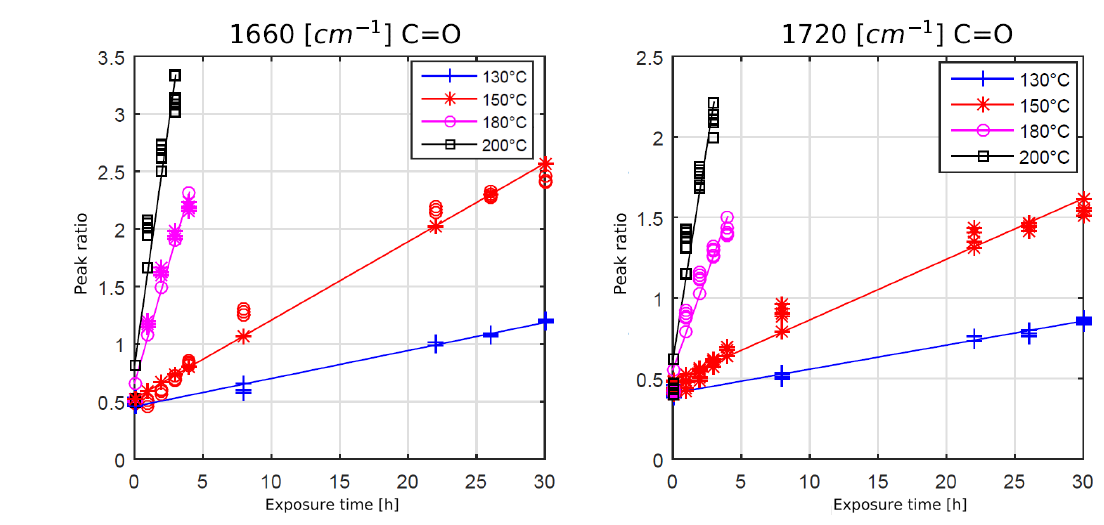
Figure 7. Development of carbonyl bonds at different temperatures and times, each approximated by a linear regression